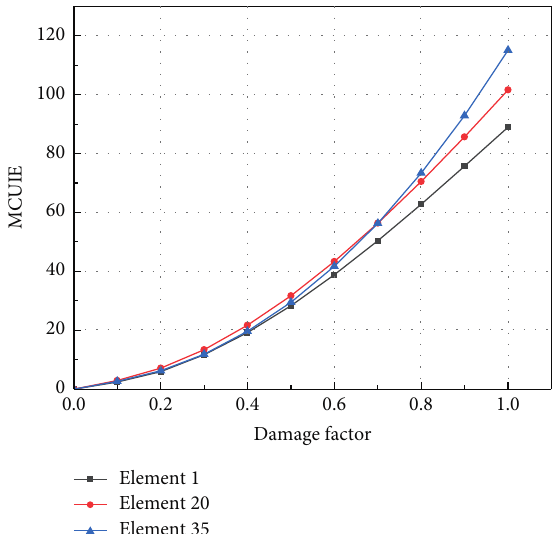
Figure 15: Damage degree fitting curve of multidamage.